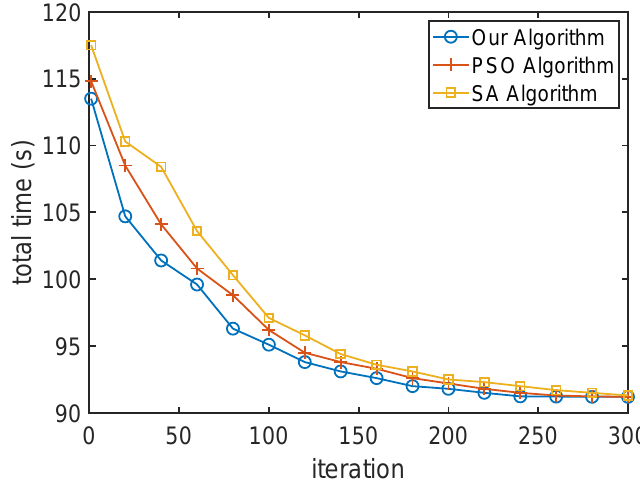
Figure 11. Convergence analysis of the 3